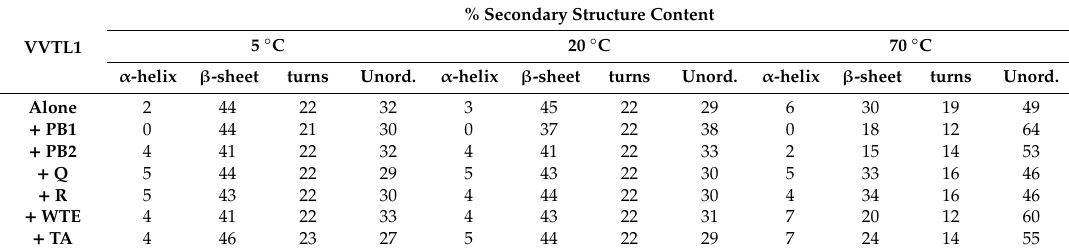
Table 1. Secondary structure content of VVTL1 (0.400 mg/mL) alone or in presence of polyphenols at 5, 20 and 70 °C. The secondary structure content was calculated by CDApps [45] using CONTINLL algorithm [46]. Unord.: unordered structure.